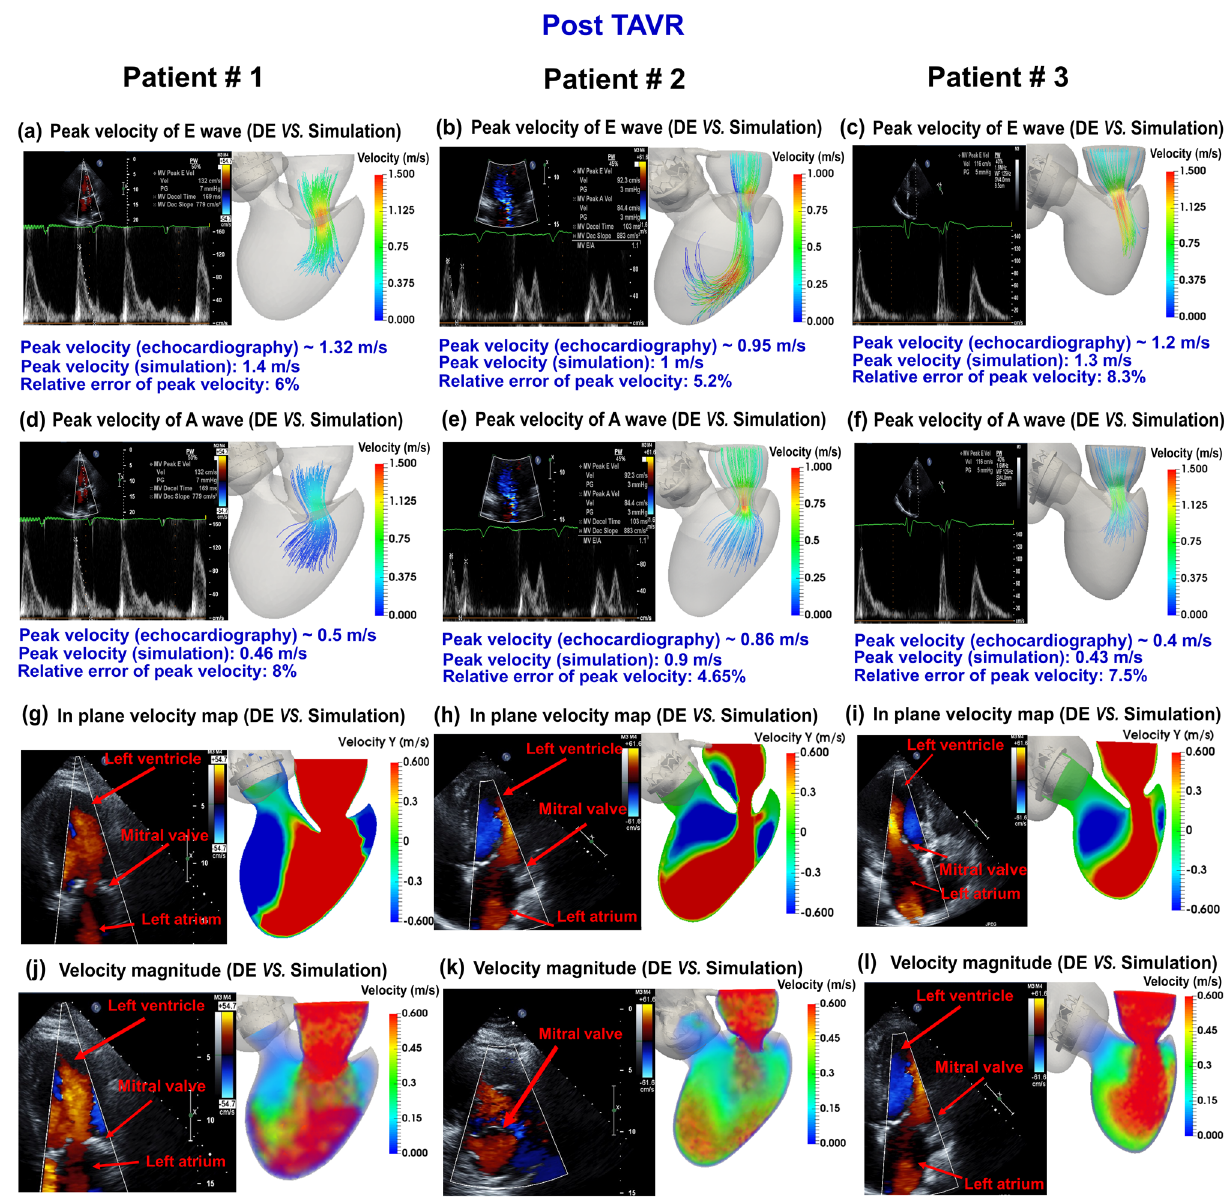
Figure 4. Validation : Doppler-based LPM and FSI framework versus clinical Doppler echocardiography data in post-TAVR condition. ( a – f ) Trans-mitral velocity during diastole in patients #1 to #3; ( g – i ) Left ventricle flow (apical view) during diastole in patients #1 to #3; ( j , l ) Trans-mitral and left ventricle flow (apical view) during diastole in patients #1 and #3; ( k ) Mitral valve flow (parasternal short axis view) in patient